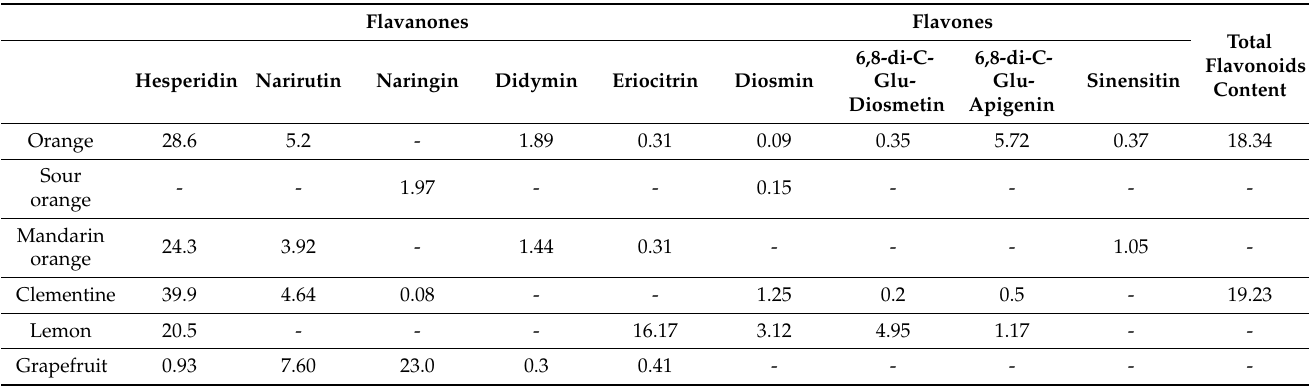
Table 3. Flavonoid composition of some Citrus juices